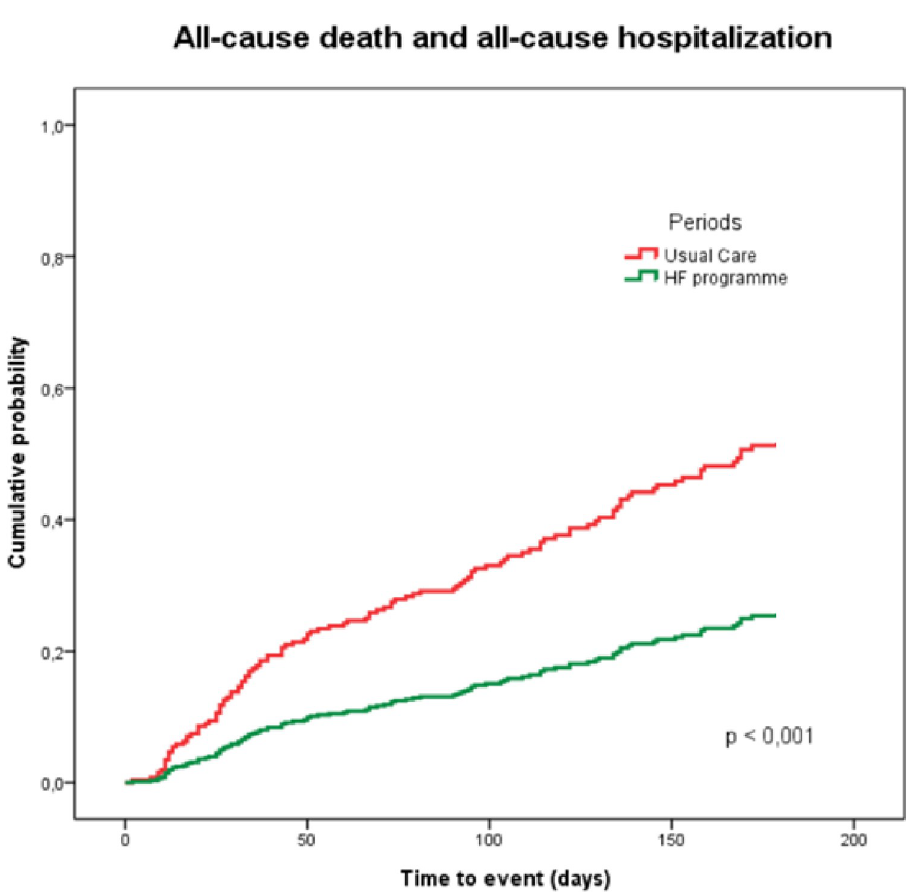
Fig 1. Adjusted time-to-event estimates for the primary endpoint according to treatment